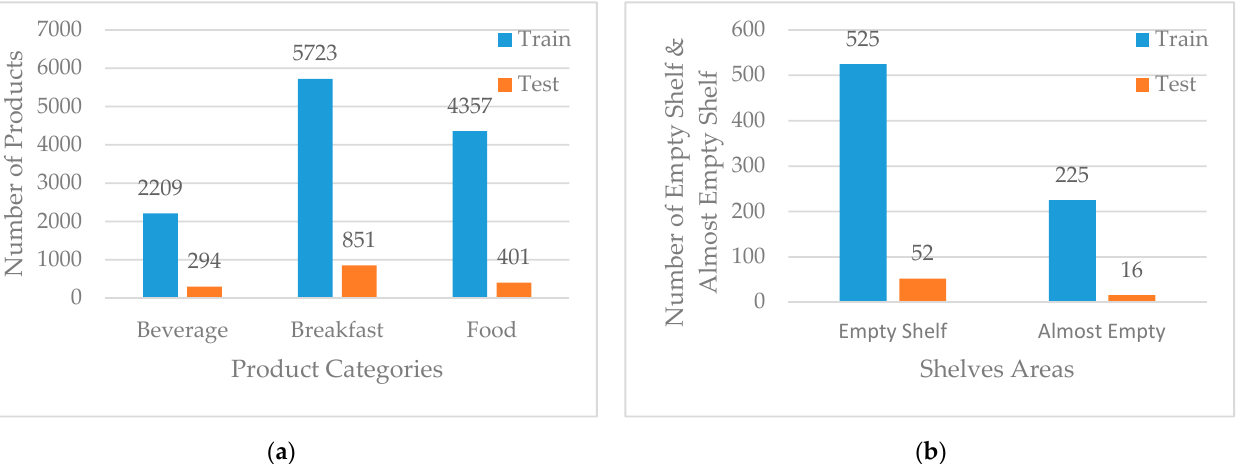
Figure 8. Structure of Pascal visual object classes (VOC) format for a sample file.